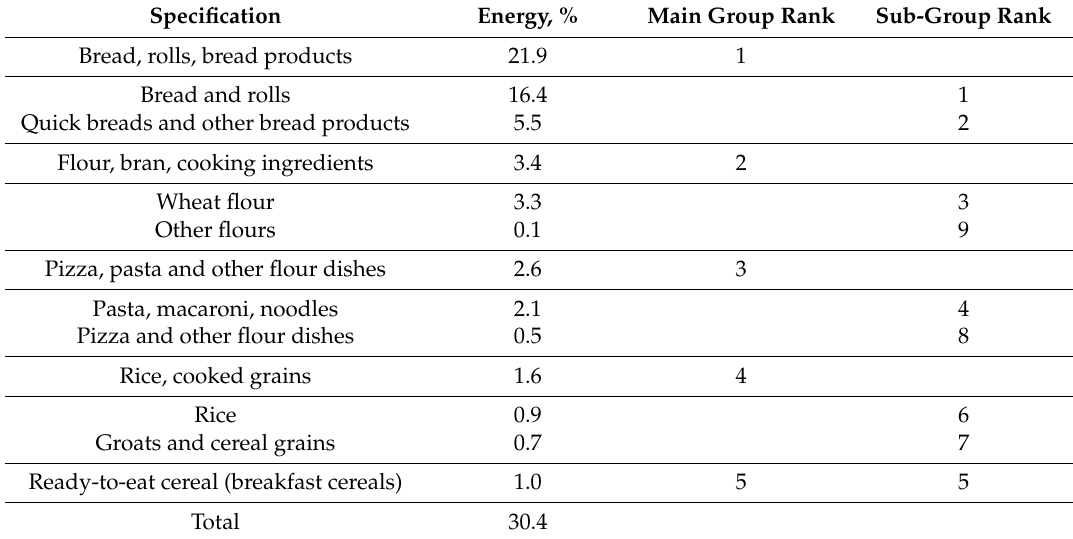
Table 3. Contribution of energy (%) from main cereal food groups and sub-groups in the average Polish diet.